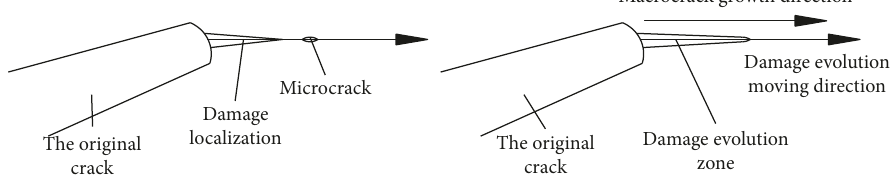
Figure 9: Growth of the original crack and its penetration with